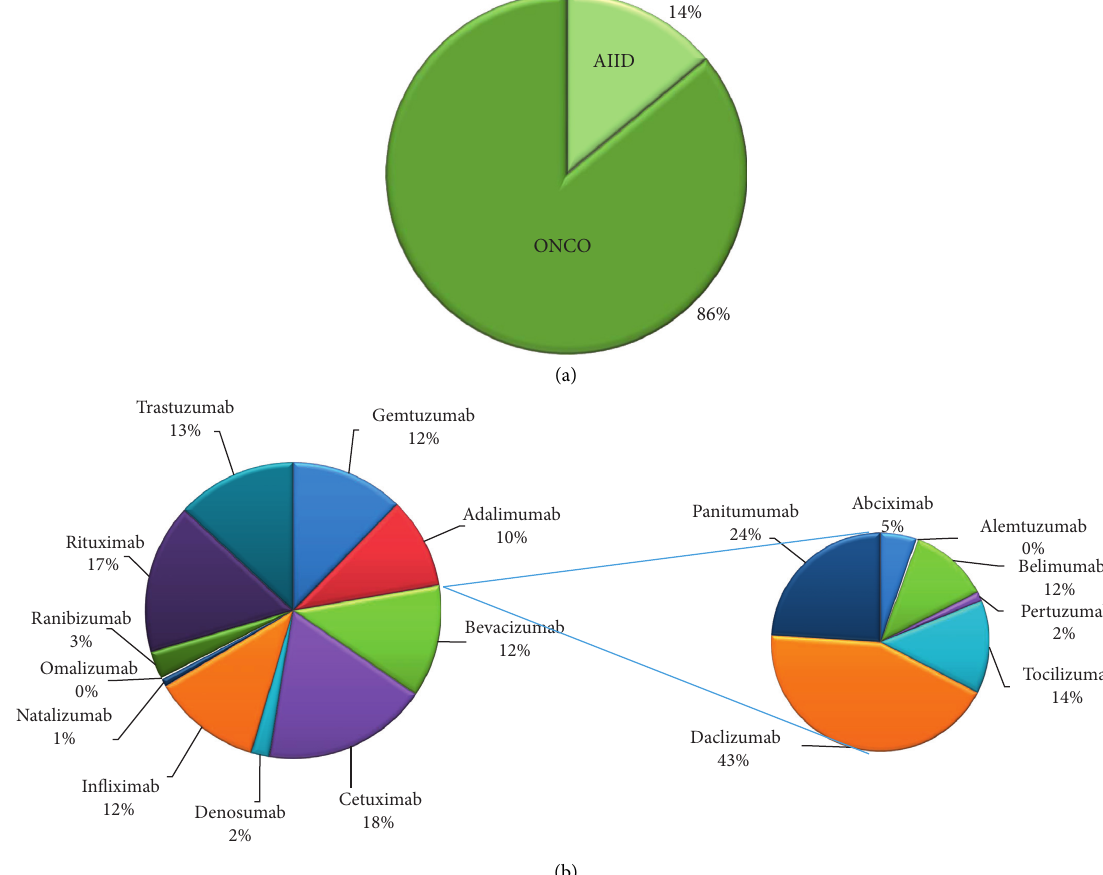
Figure 2: Monoclonal therapeutic antibodies (MTAs) in Iran from 2006 to 2018. The frequency of MTAs based on clinical application areas (a). The frequency of used MTAs by generic names